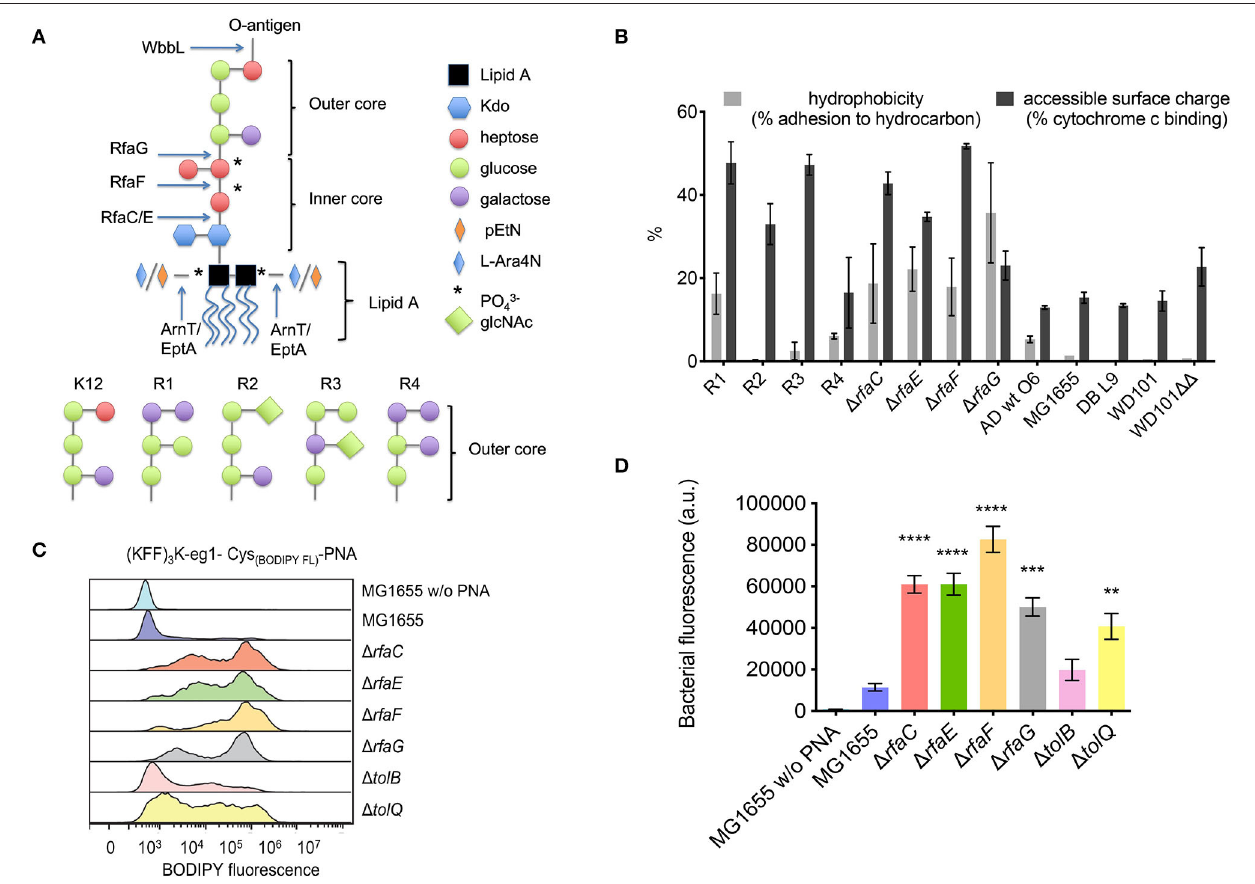
FIGURE 2 | (A) Structure of LPS inner and outer core mutants. Arrows indicate where the LPS structure terminates in the indicated mutants. RfaC and RfaF catalyze the addition of heptose, while RfaE is required for the biosynthesis of the heptose precursor and RfaG is a glucosyltransferase attaching glucose to the inner core. (B) Hydrophobicity and accessible surface charge of the tested LPS mutants as measured by adherence to hydrocarbon or cytochrome c binding, respectively. (C) Flow cytometry histogram of uptake of BODIPY fluorophore-labeled (KFF) 3 K-PNA in E. coli mutant strains. The indicated strains were incubated with 2 µ M fluorophore-labeled (KFF) 3 K-mmPNA (5873) for 1h. Flow cytometry profiles were normalized and the mean bacterial fluorescence (D) used as a measure to compare conjugate uptake. Experiments were performed in triplicates and data are represented as the mean ± SD. Student’s t -test was used to determine significant differences between the wild-type MG1655 and the mutant strains (** p < 0.01, *** p < 0.005, **** p <